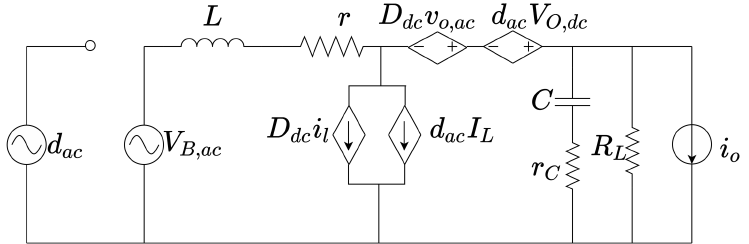
Figure 2. Small-signal model of boost converter operating in CCM (Reproduced with permission from [20], IEEE,